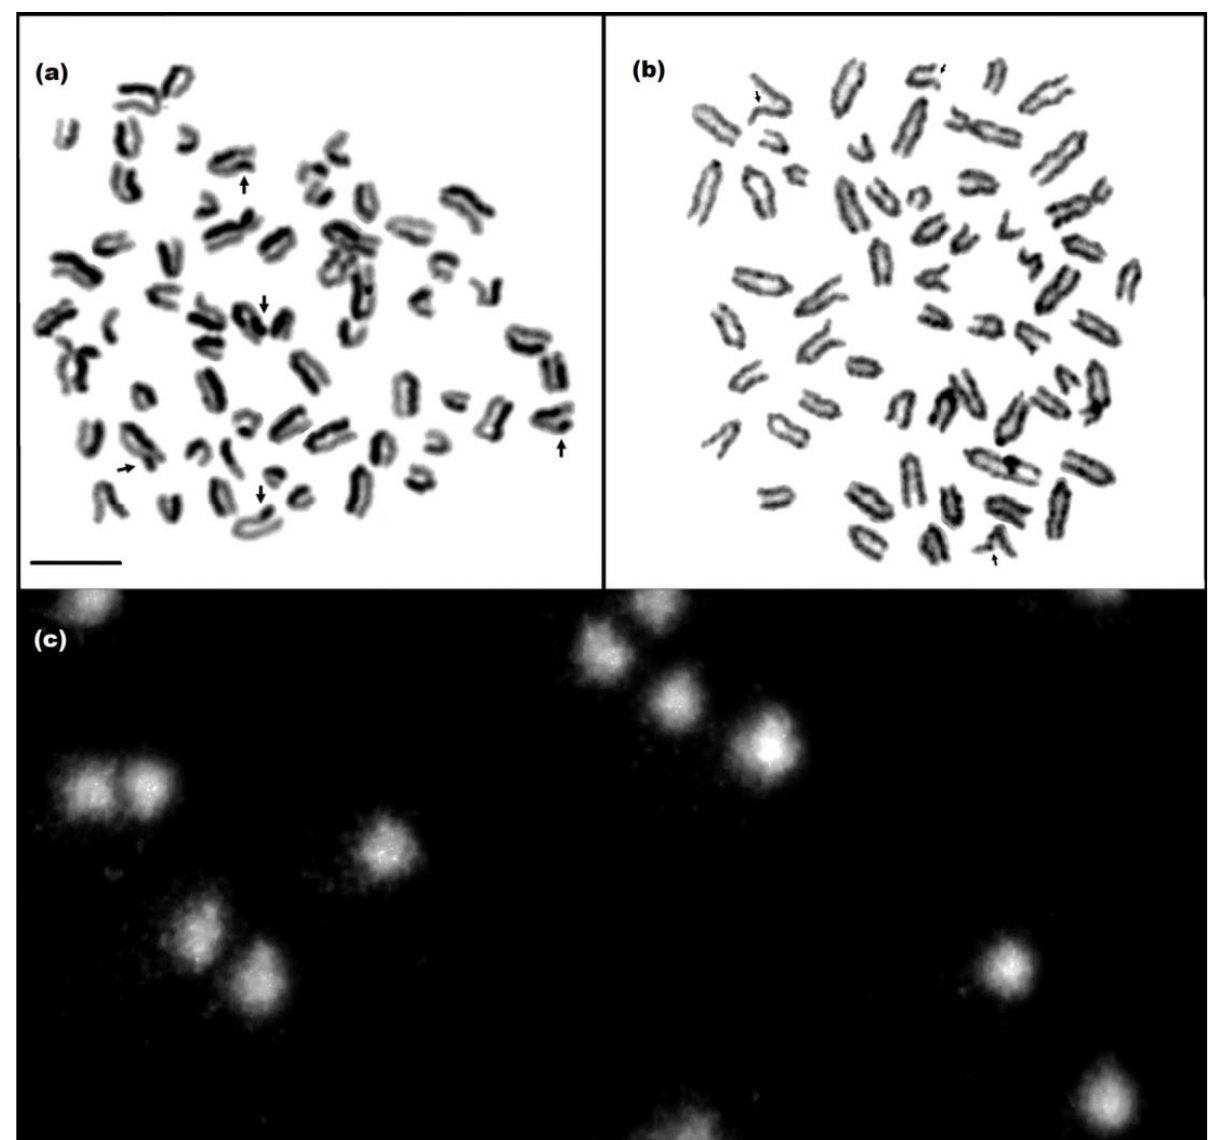
Figure 1. Mitotic chromosomes in the metaphase stained by the SCE assay ( a ) and FS assay ( b ), and cell nuclei of lymphocytes subjected to comet assay ( c ). Damage marked with arrows. Scale bar 10 µm.